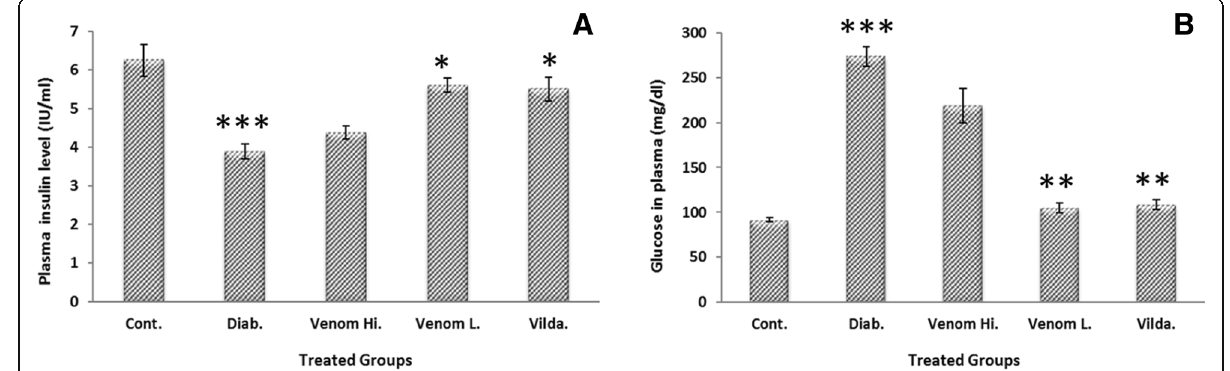
Fig. 1 a Effect of BV and vildagliptin treatment on plasma glucose level. b Effect of BV and vildagliptin treatment on insulin level. One asterisk denotes significant differences in insulin level between BV low dose and vildagliptin groups versus diabetic group. Two asterisks denote significant differences in glucose level between vildagliptin and BV low and BV high doses compared to the diabetic group. Three asterisks denote significant differences in insulin and glucose levels between diabetic and control groups, using one way ANOVA statistical analysis